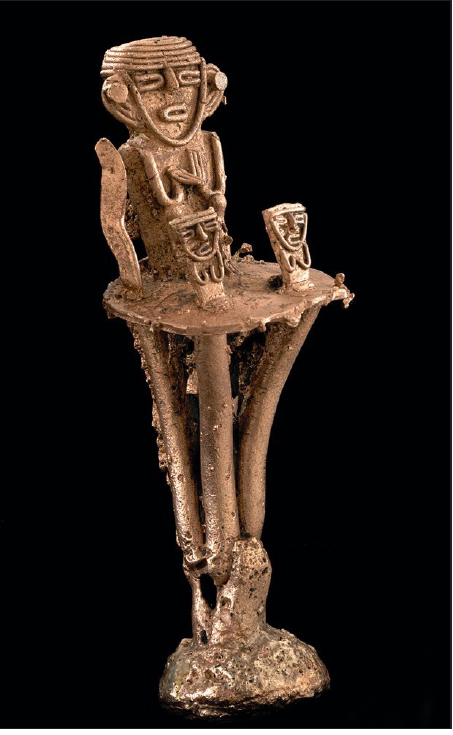
Figure 1: Muisca votive object cast in a gold- copper alloy (O15117). The object would have been cast upside down. The very prominent cast sprue cup and feeders have not been removed from the finished object. Casting flashes, and traces of clay and charcoal from the mould, are still visible in some corners and crevices. Overall height is 12.8 cm (Photo Clark M. Rodríguez, Museo del Oro, Banco de la of the permanent displays at the Museum, including that of the popular Muisca raft. Nahuange Goldwork, Changing Colours and Object Biographies